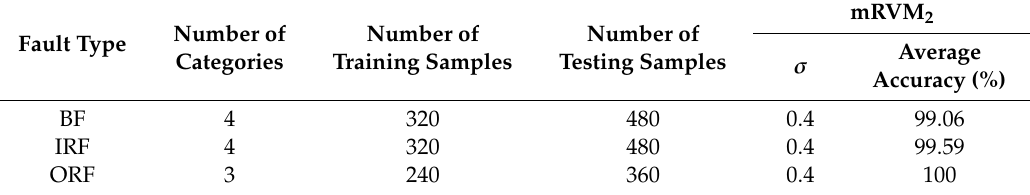
Table 6. Fault diameter identification accuracy with the same fault type irrespective of the load.